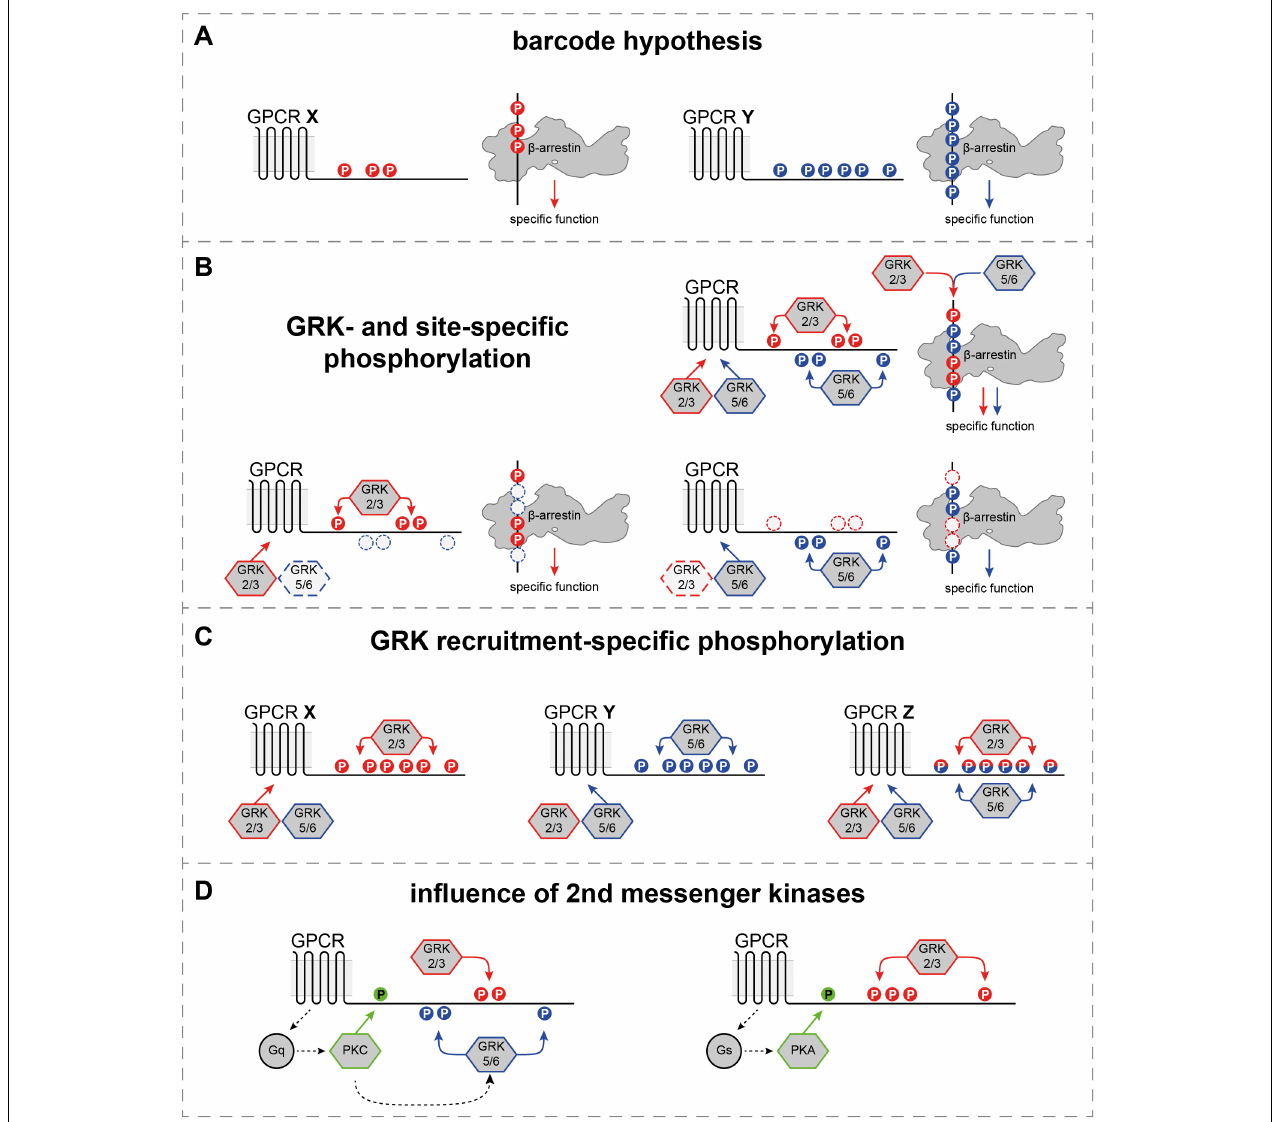
FIGURE 2 | Differential and GRK-specific GPCR phosphorylation induces distinct β -arrestin mediated functions. (A) The most straightforward way to interpret the “barcode” hypothesis, as different GPCRs feature different C-terminal phosphorylation patterns to induce distinct β -arrestin functions. (B) Individual GRK isoforms or families (GRK2/3 or GRK5/6) have been shown to preferentially phosphorylate specific sites at different GPCR C-termini (Nobles et al., 2011; Doll et al., 2012; Miess et al., 2018). Depending on the availability of kinases in a cellular system, the same GPCR could be phosphorylated by GRK2/3 or GRK5/6 only, to induce specific functions, or by all GRK isoforms to achieve the activation of all possible β -arrestin functions. (C) Certain GPCRs have been shown to be functionally phosphorylated by GRK2/3 only, or GRK2/3/5/6 (Drube et al., 2021). This might constitute another layer of coupling preference at the foundation of the “barcode” hypothesis. (D) Second messenger kinases, like PKC and PKA are activated by the primary G protein signaling and have been shown to phosphorylate GPCRs directly. Additionally, they are able to modulate the activity of certain GRK isoforms or families (Chuang et al., 1995; Winstel et al., 1996; Pronin and Benovic,